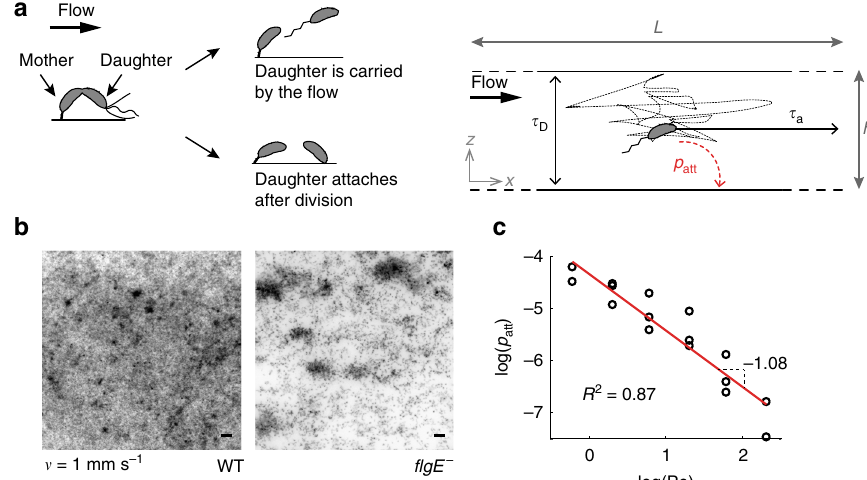
Fig. 2 Physical mechanism for modulation of C. crescentus bio fi lm architecture. a C. crescentus divides asymmetrically: the mother cell is anchored to the surface and undergoing division. At the time of division, a daughter cell can either attach to the surface or be carried by the fl ow. If attachment occurs, the daughter immediately synthesizes a holdfast contributing to clonal expansion on the surface. If the daughter cell does not attach to the surface, it is subject to: (i) advective transport by fl uid fl ow and (ii) diffusion-like transport generated by unbiased swimming. b Contribution of bacterial motility to surface colonization patterns. Fluorescence microscopy images of wild-type (WT) or fl agellum-less ( fl gE − ) C. crescentus after 24 h exposure to fl uid fl ow (1 mm s − 1 ). Surface colonization by the fl gE − mutant is slower and less saturated than WT. This qualitatively recapitulates the results observed in stronger fl ow for WT. Scale bars: 10 μ m. c Attachment probability (attachment rate normalized by total bacterial fl ux) as a function of the Péclet number (Pe) on a logarithmic scale. A linear fi t of the data indicates swarmer adhesion probability scales with Pe − 1 , as suggested by our advective-diffusion